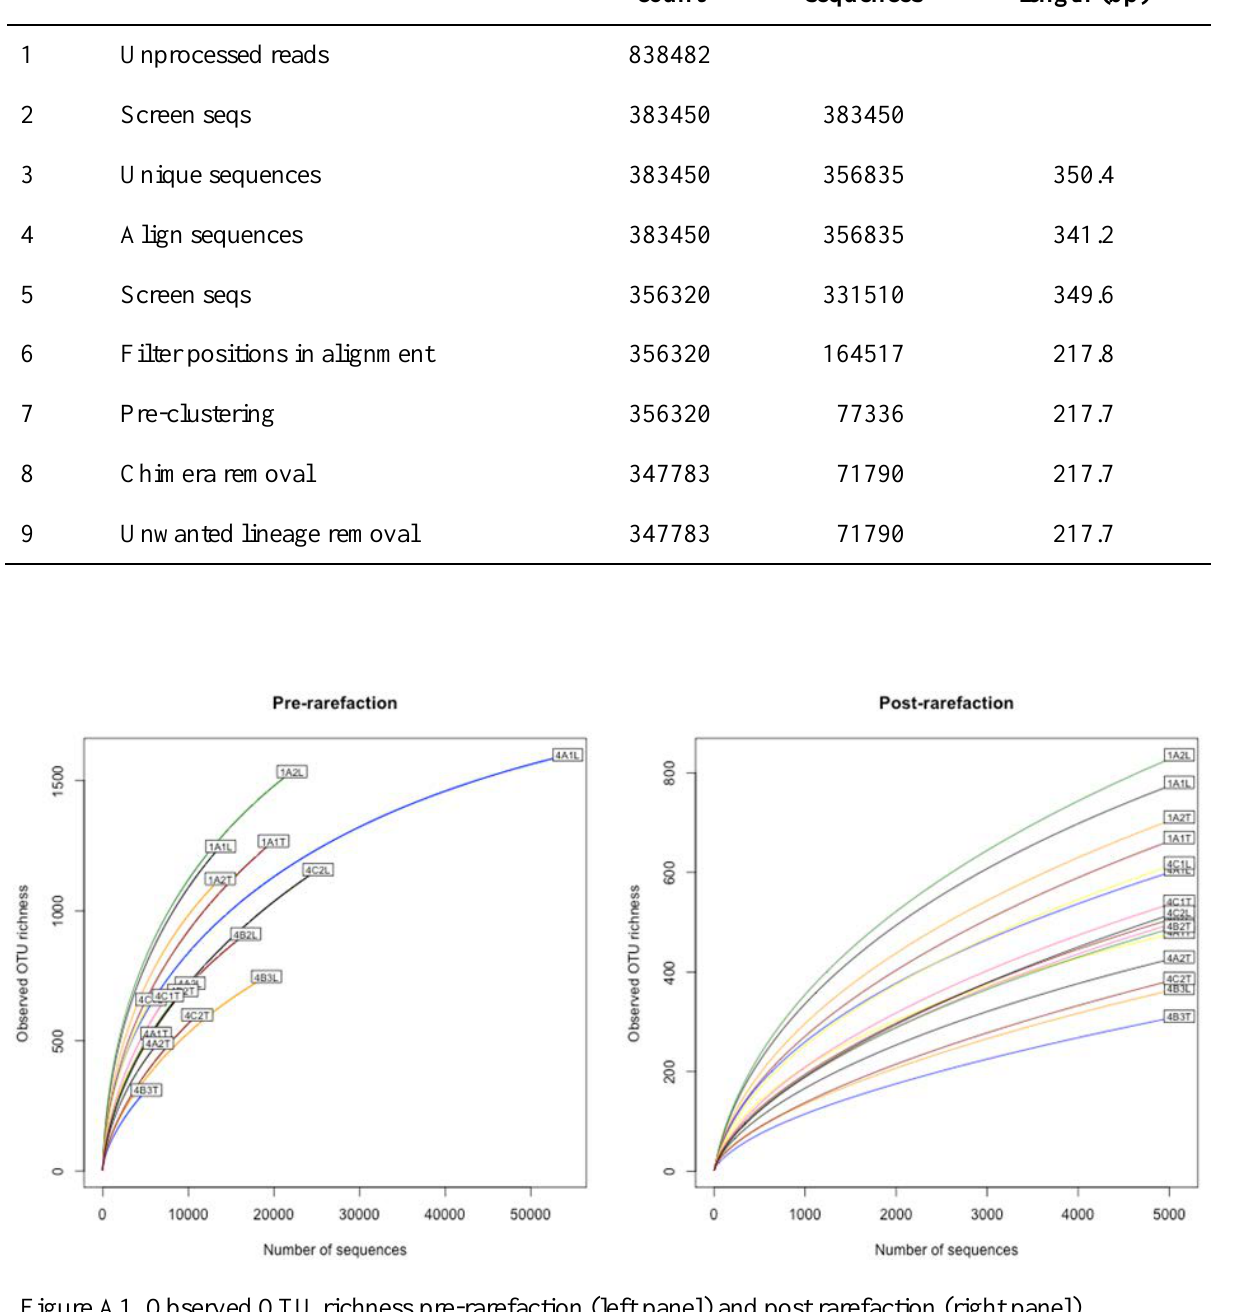
Figure A1. Observed OTU richness pre-rarefaction (left panel) and post rarefaction (right